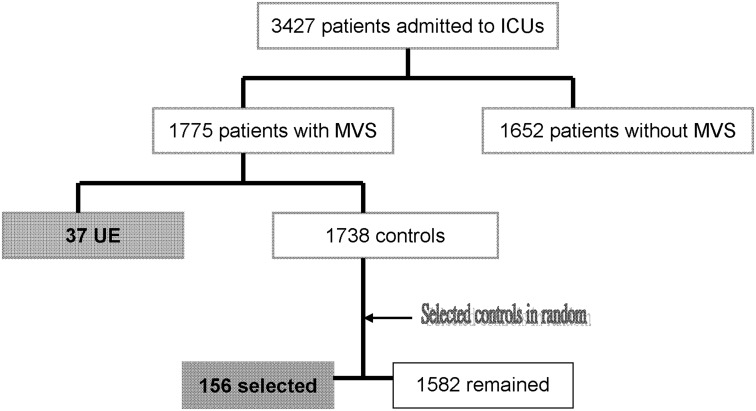
Flow Diagram.The frequencies of annual admission to intensive care units (ICUs), mechanical ventilatory support (MVS), and unplanned extubation (UE). Controls are the subjects without UE.